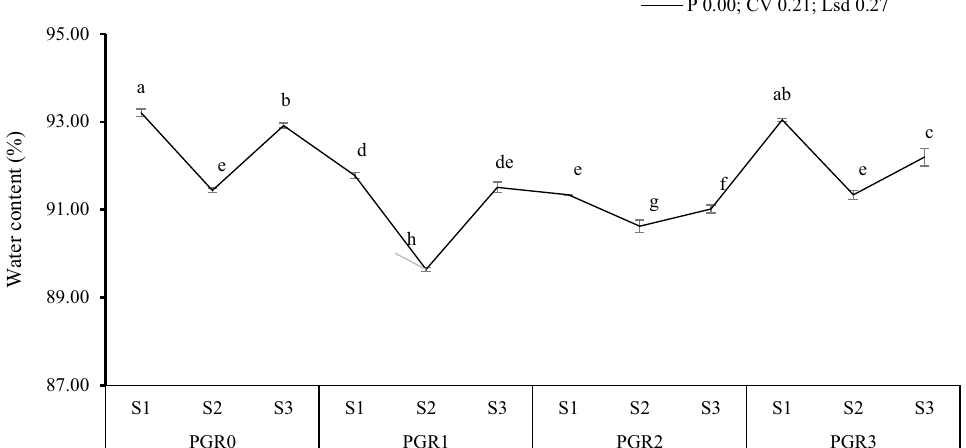
Fig. 4 Interaction effect of plant growth regulators and application stage on the water content of fruit. Abbreviations are as follows: PGR 0 : 0, PGR 1 : 100 mgL − 1 GA 3 , PGR 2 : 100 mgL − 1 NAA and PGR 3 : 100 mgL − 1 MH (maleic hydrazide), S 1 : seed soaking stage, S 2 : 4-leaf stage and S 3 : flower bud stage. Different letters in the same column indicate significant differences between treatments ( p < 0.05). Vertical bars indicate standard